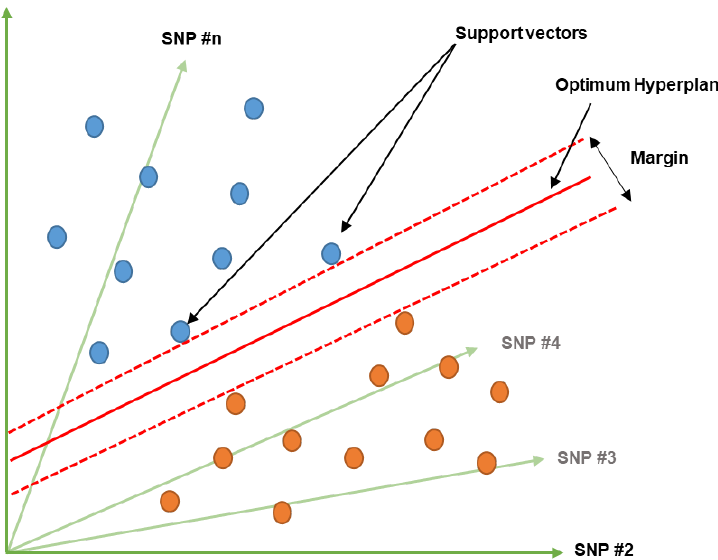
Figure 2. Schematic illustration of a support vector machine used for classifying two sets using SNPs dataset. Red dashed lines illustrate the possible margin among support vectors from two different classes, shown in blue and orange. This figure was created using Excel, Microsoft Office 2021.